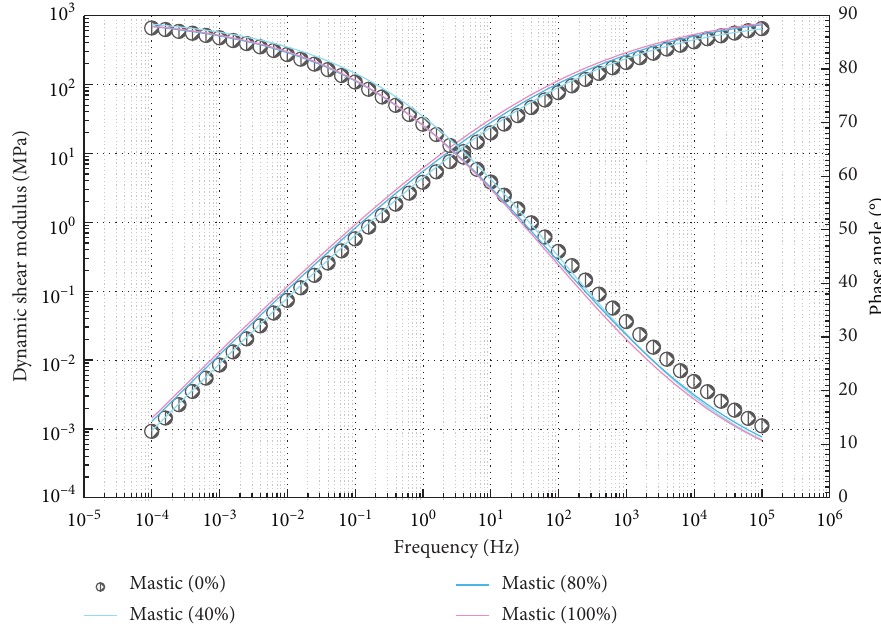
Figure 8: Complex modulus master curves of asphalt mastic. Table 5: Relative differences in complex modulus